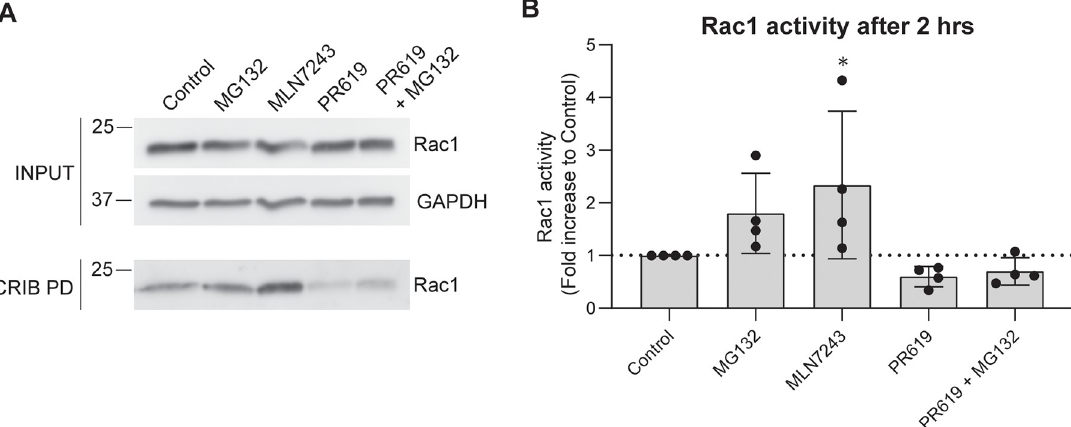
Fig 1. Rac1 activity is regulated by the ubiquitin-proteasome system. A) Representative western blot analysis of Rac1-GTP by CRIB pulldown (PD). HUVECs were treated for 2 hrs with the indicated inhibitors and pulldown of endogenous active Rac1 was performed as described in materials and methods. B) Quantification of Rac1 activity by densitometric analysis of western blot after CRIB pulldown (n = 4). � p < 0.05 compared to control in Holm-Sidak’s post-hoc test of one-way ANOVA.